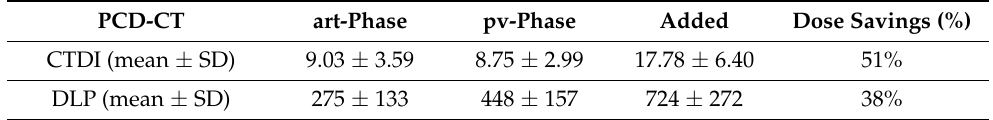
Table 16. Art-phase: arterial upper abdomen phase; pv-phase: portal venous abdominal phase (including also the pelvic region); CTDI: computed tomography dose index; DLP: dose-length product; SD: standard